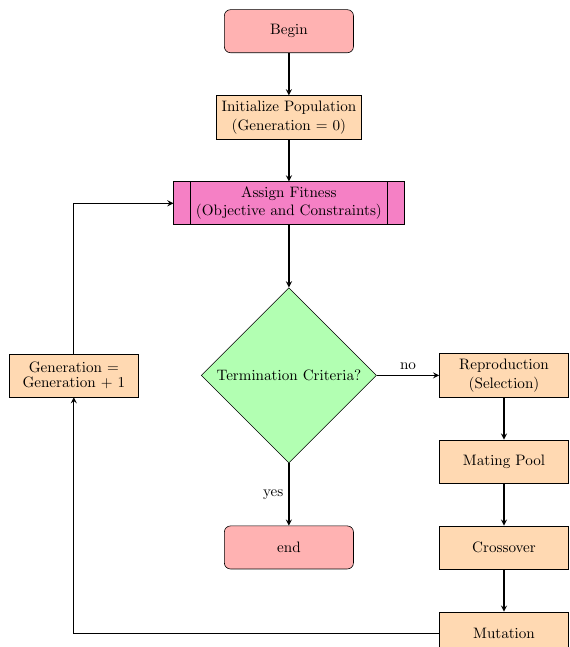
Figure 4. Flowchart of the